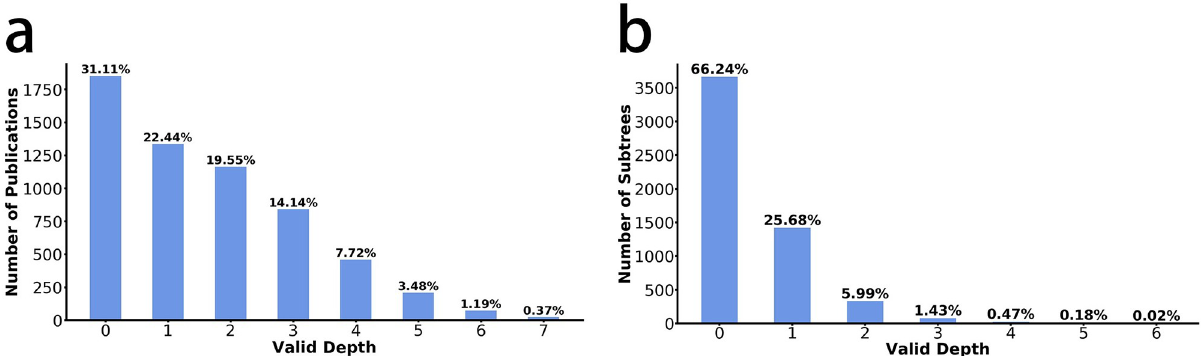
Fig 2. The distribution of high-impact publications’ VD and the distribution of the VD inspired by a single article within idea trees. The VD of 99% of high-impact publications is difficult to exceed six-hop. (b) 99% of the articles in the idea tree have difficulty contributing more than three-hop to the